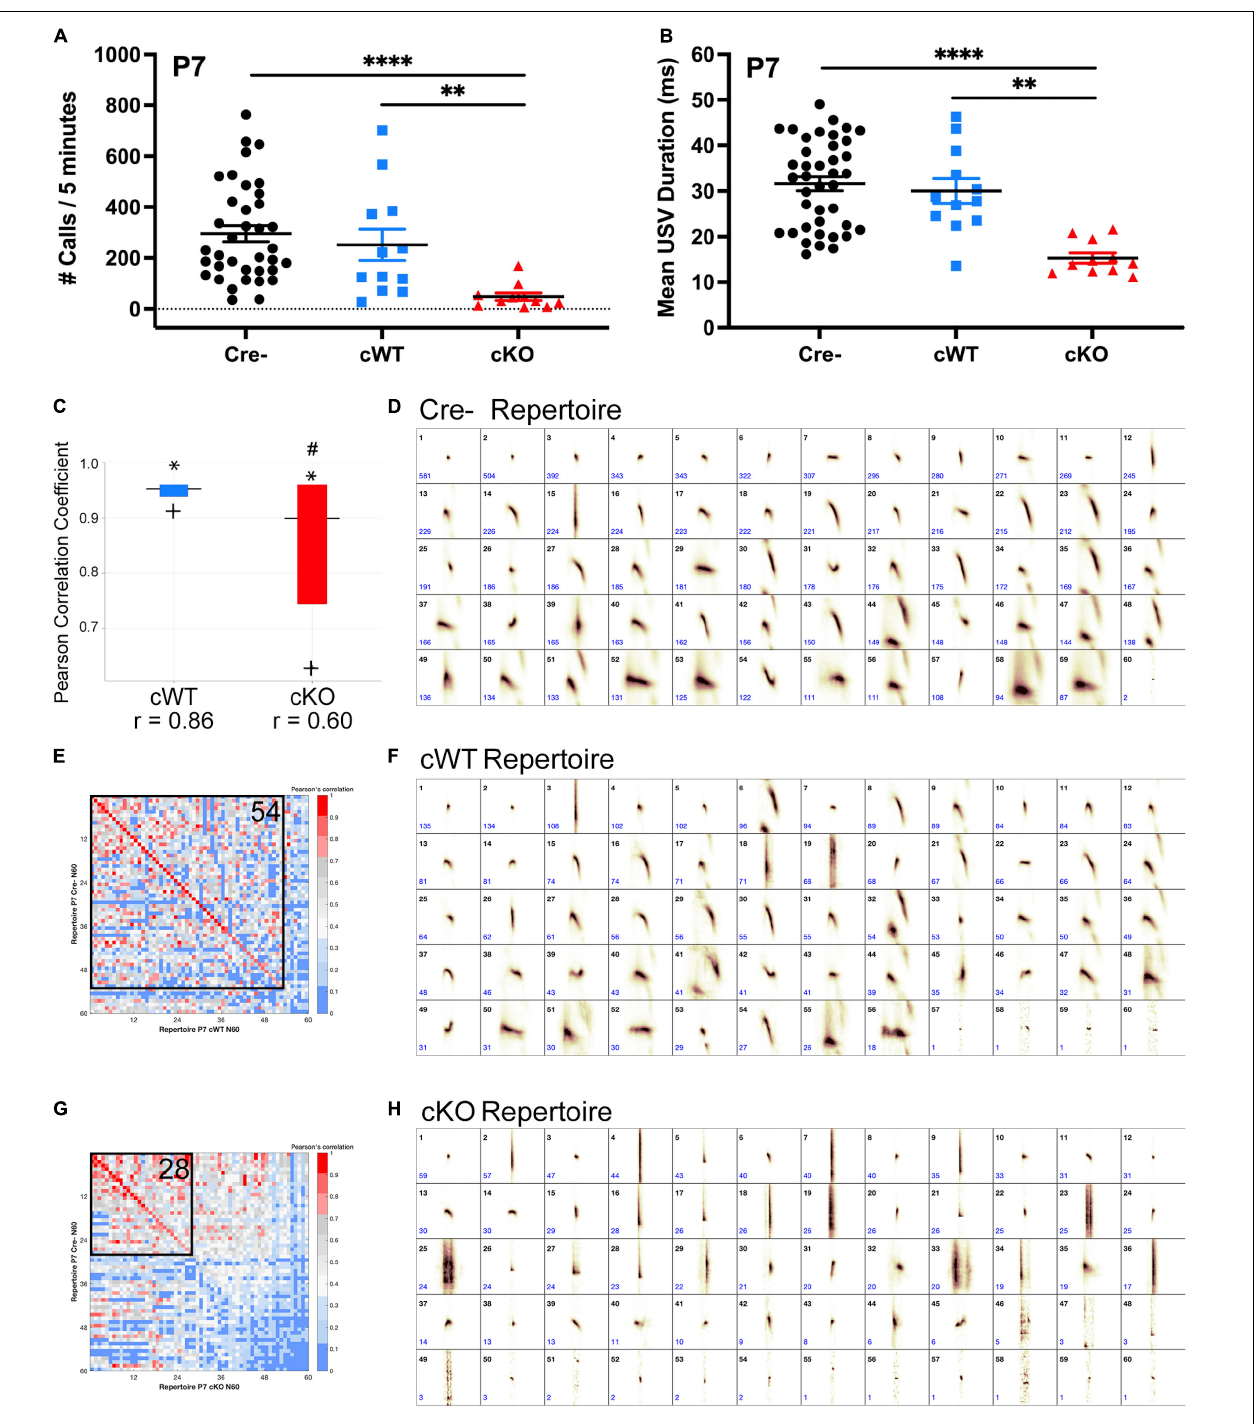
FIGURE 1 | Deletion of MET results in severely impaired ultrasonic vocal production and syllable repertoire early postnatally. (A) Quantification of the number of isolation-evoked USVs over the 5-min recording period on P7. n = 37 Cre-, n = 12 cWT, n = 11 cKO. “ ∗∗ ” indicates p < 0.01, “ ∗∗∗∗ ” indicates p < 0.0001 as analyzed by non-parametric Kruskal-Wallis test and Dunn’s correction for multiple comparisons. (B) Quantification of the duration of isolation-evoked USVs over the 5-min recording period on P7. n = 37 Cre-, n = 12 cWT, n = 11 cKO. “ ∗∗ ” indicates p < 0.01, “ ∗∗∗∗ ” indicates p < 0.0001 as analyzed by non-parametric Kruskal-Wallis test and Dunn’s correction for multiple comparisons. (C) MUPET boxplot comparing the Cre- repertoire to the cWT repertoire (blue) or cKO repertoire (red). Similarity of the top 5% most frequently used RUs in the Cre negative repertoire indicated by ∗ . Similarity of the top 25% most frequently used RUs in the Cre negative repertoire indicated by top of the box. Similarity of the top 50% most frequently used RUs in the Cre- repertoire indicated by the horizontal line. Similarity of